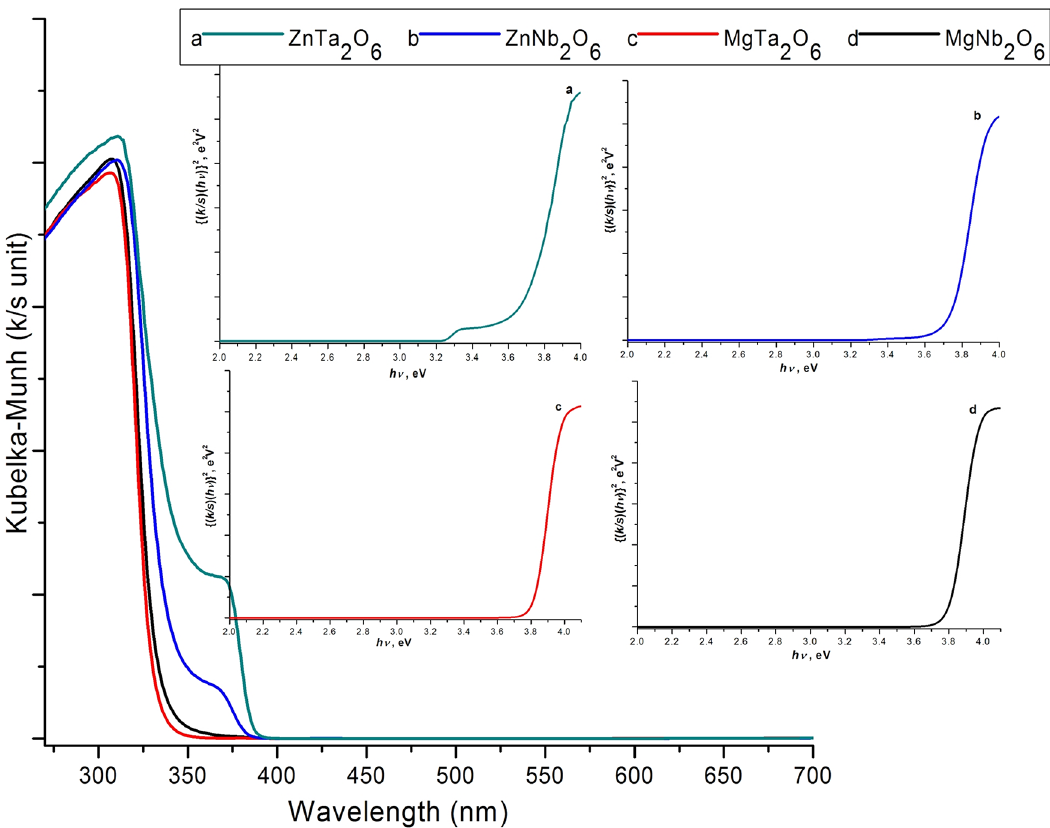
Fig. 5. Absorption spectra of (a) ZnTa 2 O 6 , (b) ZnNb 2 O 6 , (c) MgTa 2 O 6 and (d) MgNb 2 O 6 nanomaterials. From the inset plot were obtained the optical band gaps.